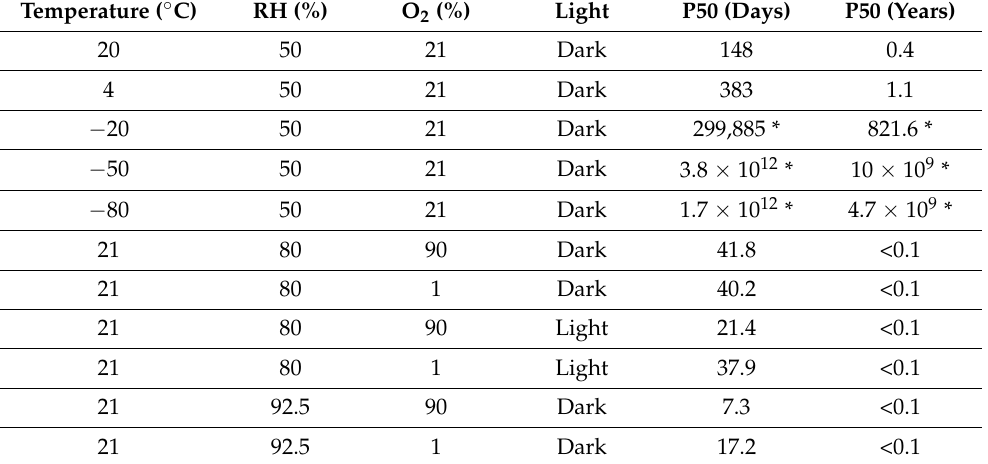
Table 1. Effect of storage conditions on H. lacustris cell longevity (P50).